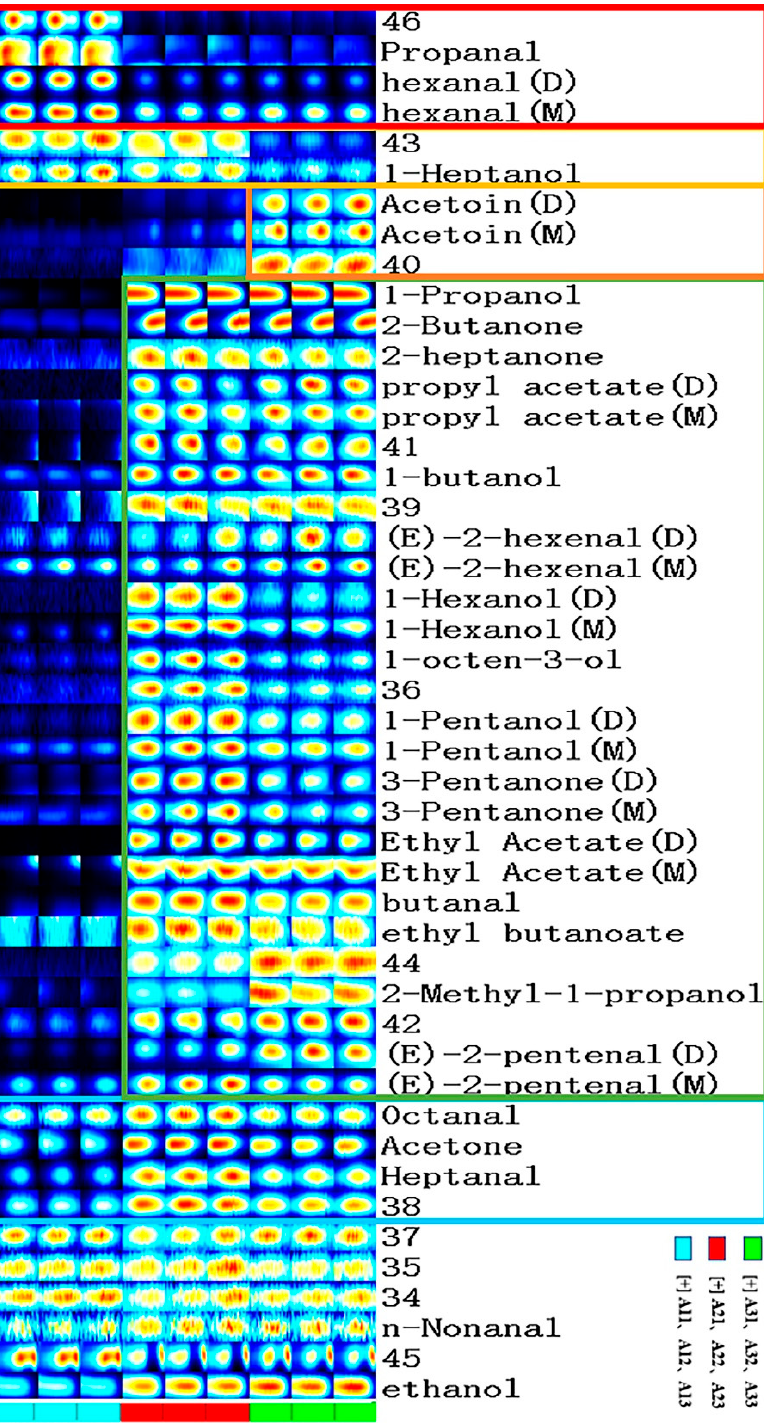
Figure 5. Gallery plot of tuna samples with different treatments. The volatile components in A2 and A3 were far more complex than those in A1, indicating that volatile flavor increased with storage time. In the red box, the intensity of components in A1 was much stronger, including propanal and hexanal, indicating that they were unique volatile components of fresh tuna samples, which conformed with the study of Zhang [32]. In the yellow box, the intensity of signal in A1 and A2 were much higher than that of A1, including 1-heptanol, indicating that CP treatment would destroy part of the volatile component that originally existed in the tuna. In the orange box, the intensity of A3 was much higher than the others, including acetoin, indicating that acetoin was the characteristic volatile component produced by CP. In the deep green box, the